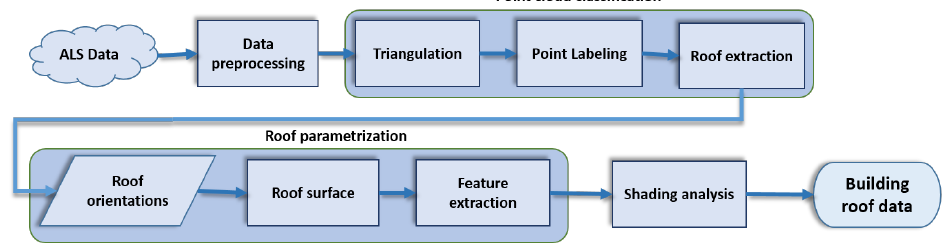
Figure 1. Methodology workflow.